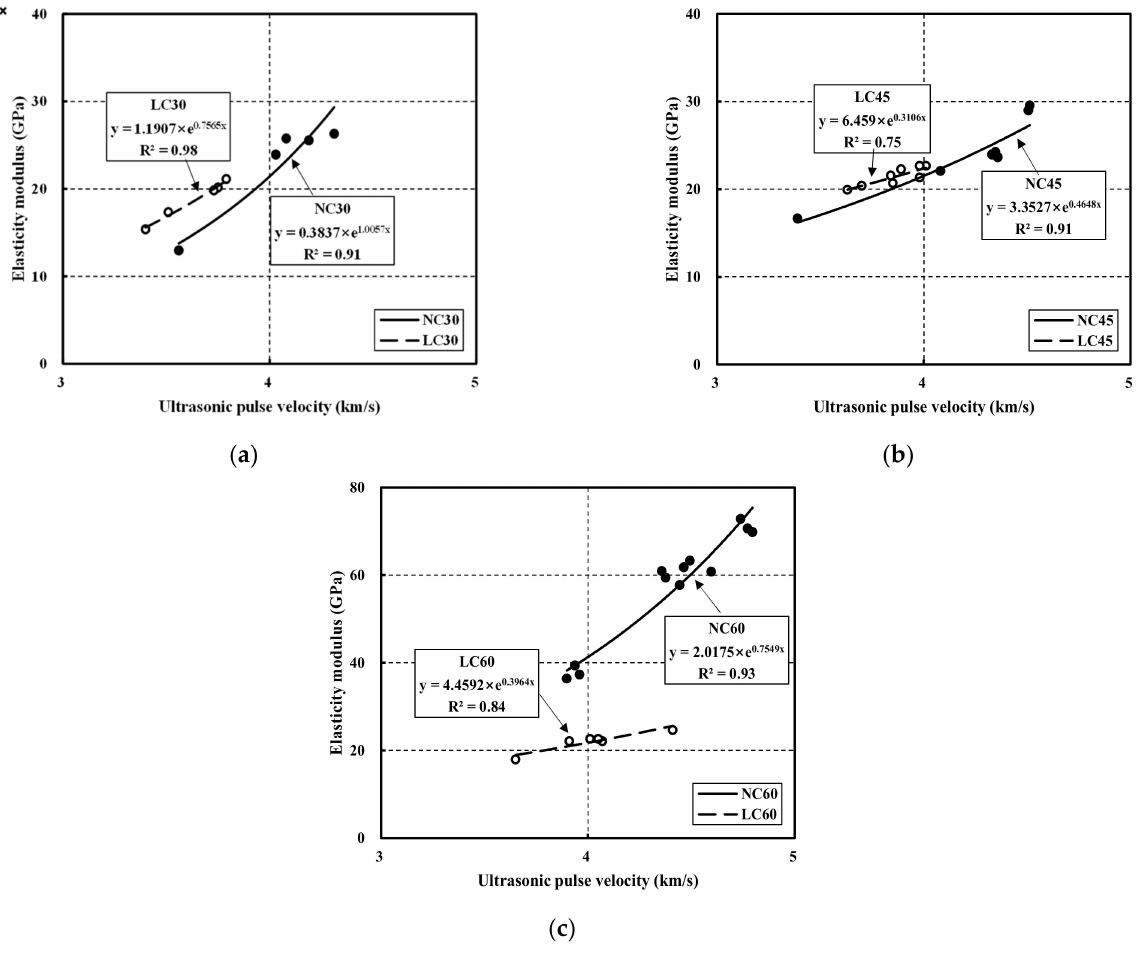
Figure 7. Relationship between elastic modulus and ultrasonic pulse velocity in normal aggregate concrete and lightweight aggregate concrete: ( a ) 30 MPa; ( b ) 45 MPa; ( c ) 60